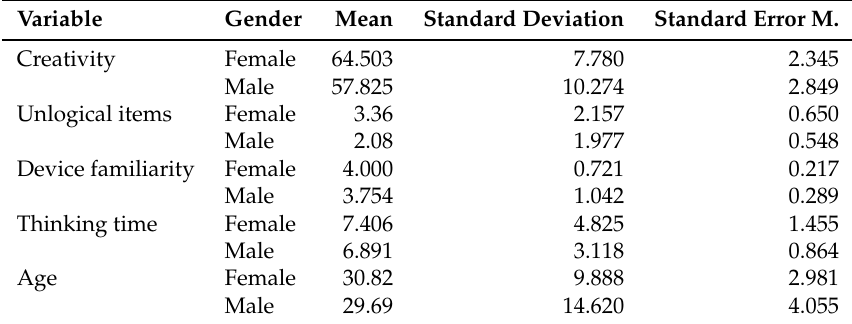
Table 1. Descriptive statistics of variables by genre.